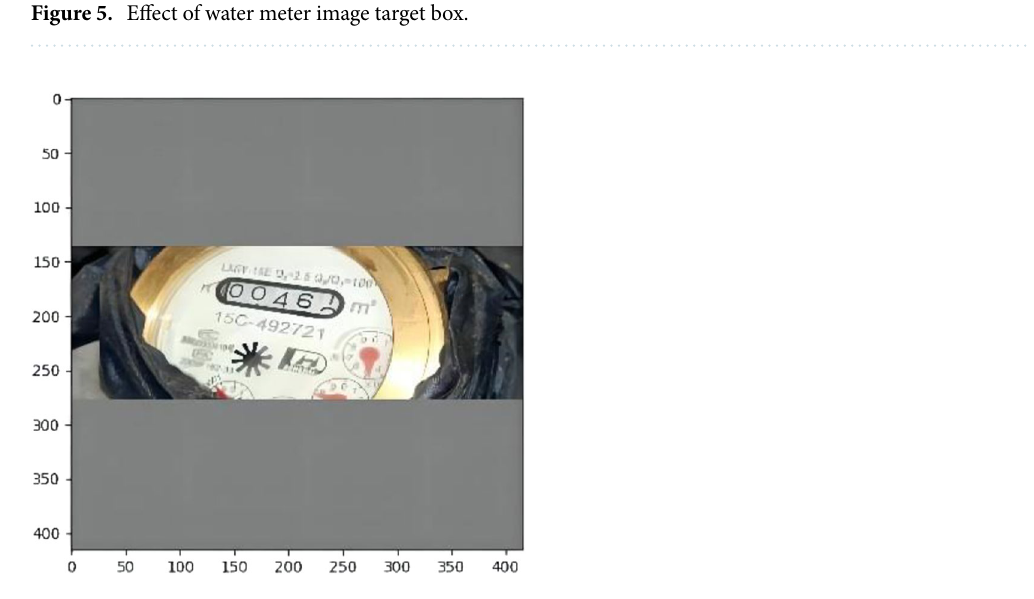
Figure 6. Image of water meter with uniform